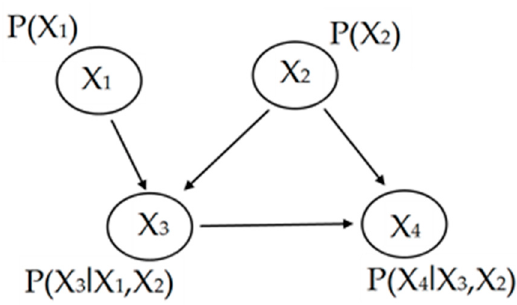
Figure 1. Example model of a Bayesian network.